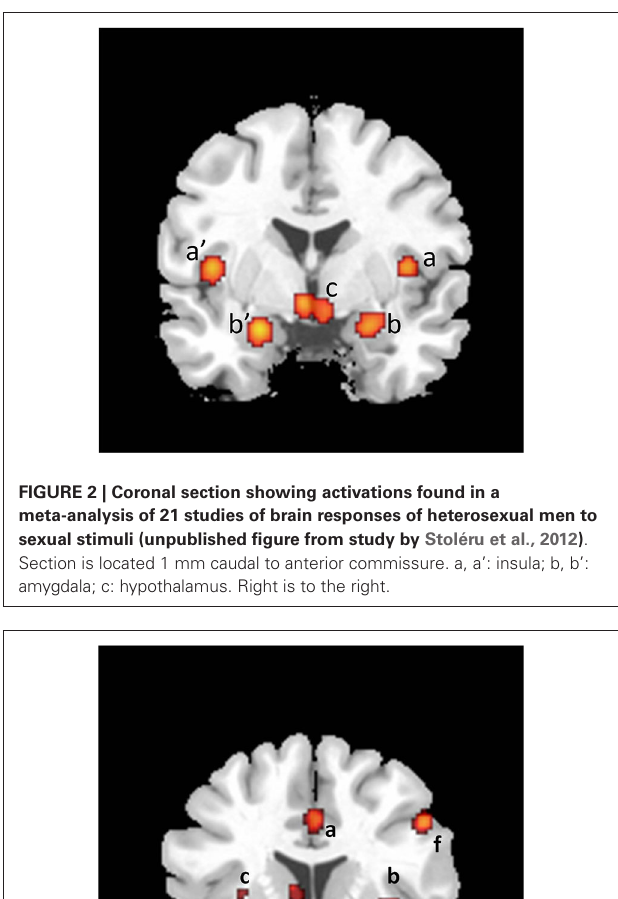
FIGURE 3 | Coronal section showing activations found in a meta-analysis of 21 studies of brain responses of heterosexual men to sexual stimuli (unpublished figure from study by Stoléru et al., 2012). Section is located 14 mm rostral to anterior commissure. a: